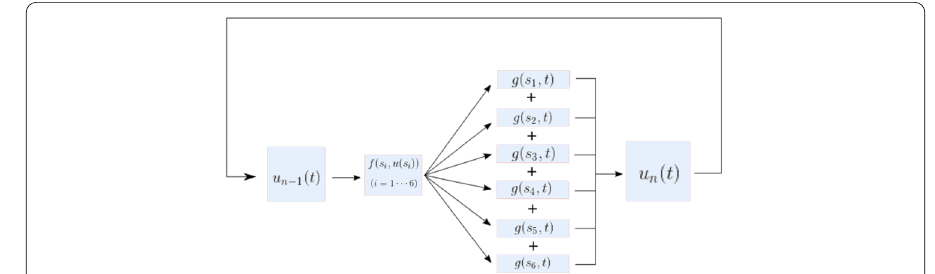
(cid:5) Ω g ( s , t ) f ( s , u n –1 ( s ))